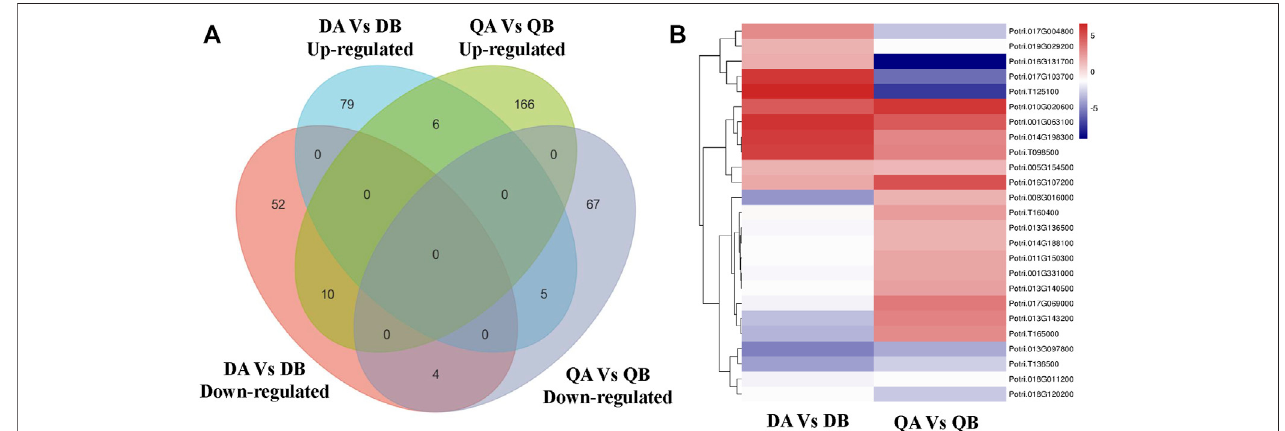
FIGURE 8 | Venn diagram (A) and heatmap (B) showing co-expressed DEGs in the DA vs. DB and QA vs. QB